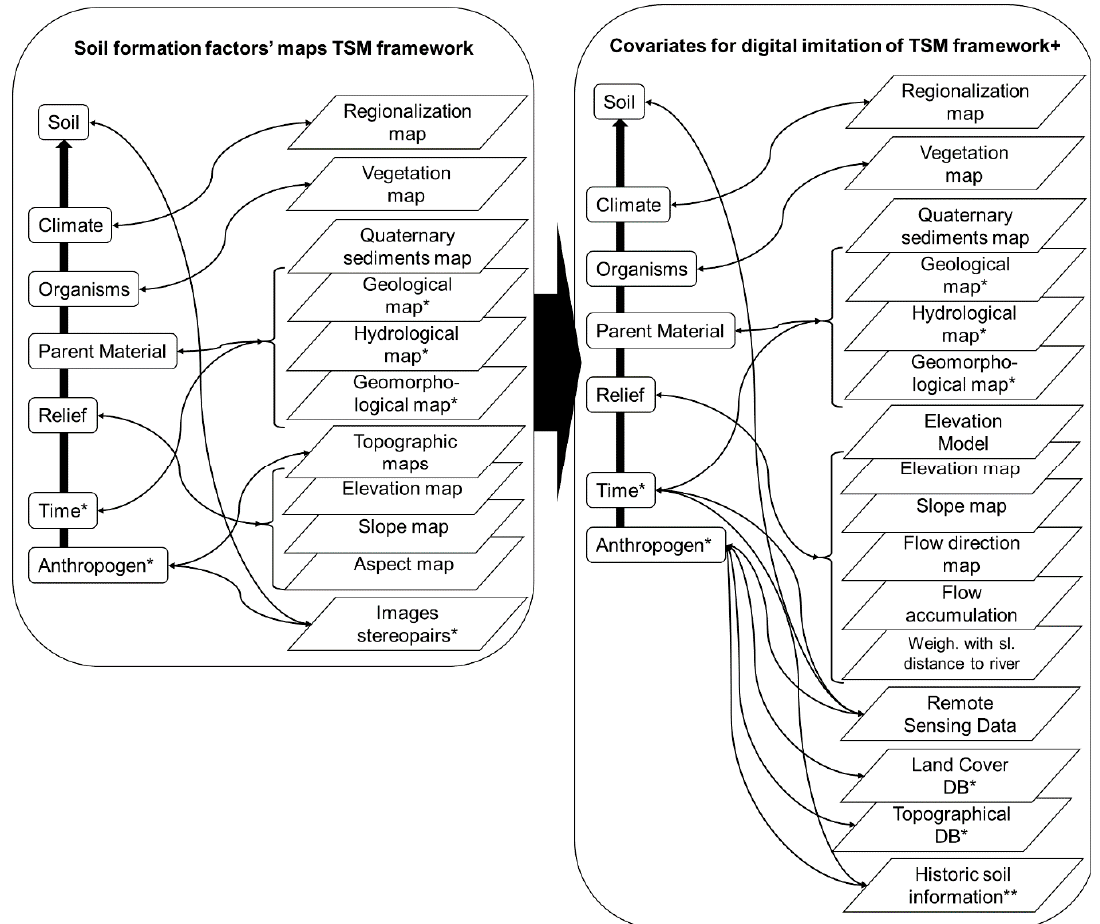
Figure 2. Covariates from the traditional methodology of soil mapping with additional maps of the elevation model derivatives (*—optionally used maps and **—historical information about soils that are required for correct monosemantic soil delineation via the soil formation factor approach). Table 3. Description of the developed covariates.